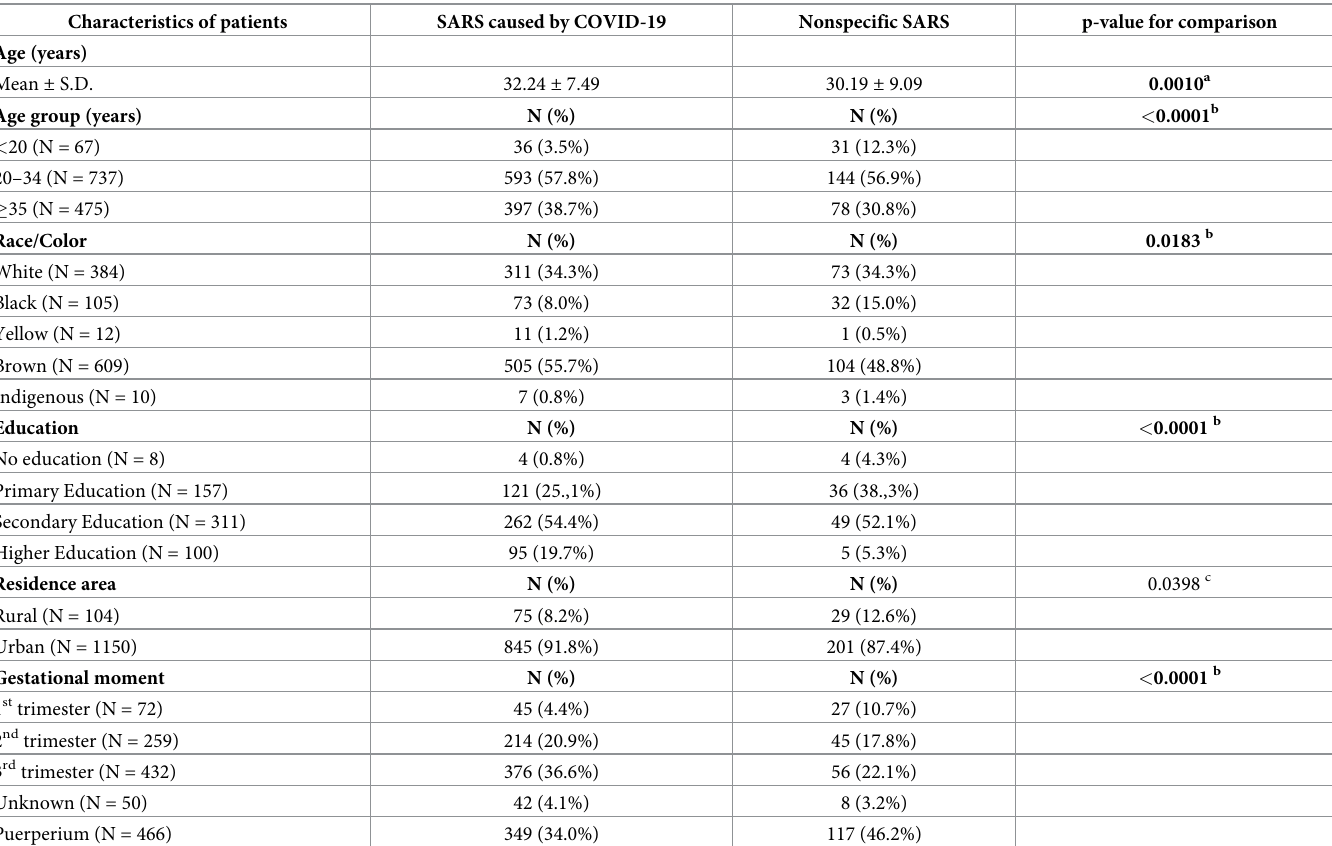
Table 1. Demographic characteristics of pregnant and postpartum women who died from SARS according to the cause (COVID-19 or nonspecific). Characteristics of patients